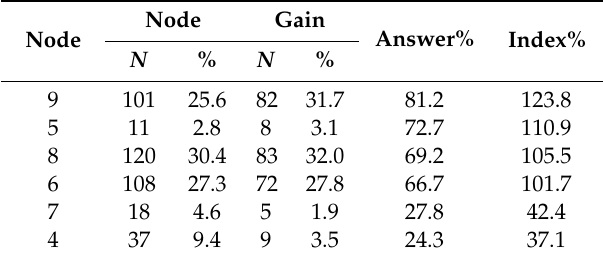
Table 3. Earnings for nodes: target those who do use YouTube.